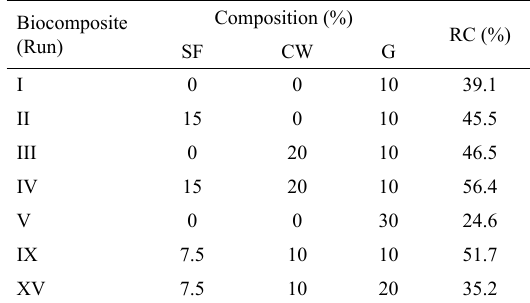
Table 2. Relative crystallinity (RC) for selected biocomposites Biocomposite